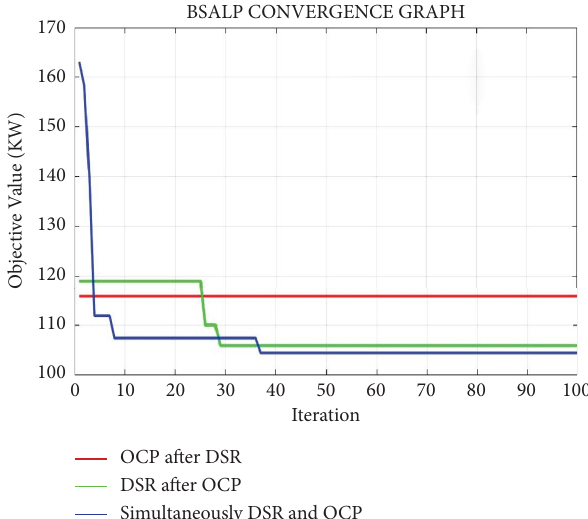
Figure 12: Convergence active power losses (kW) for 33-bus using the suggested BSSA